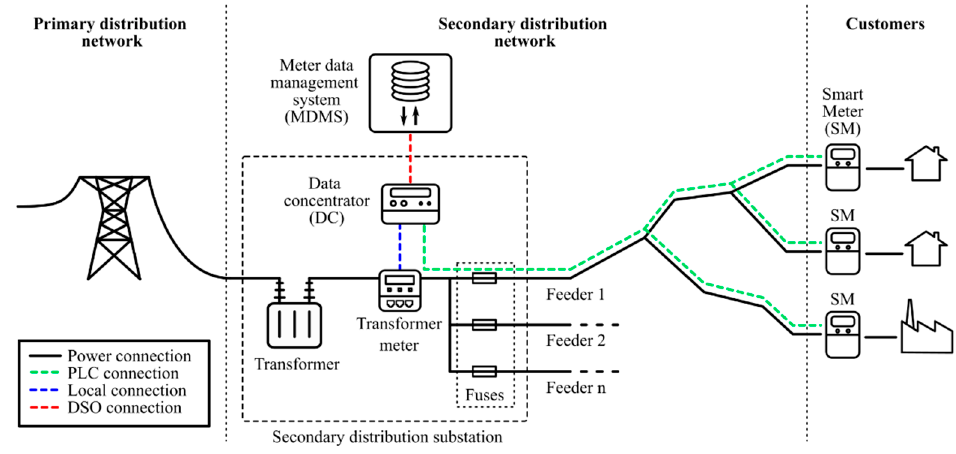
Figure 1. PLC (Power Line Communication)-based smart metering infrastructure [38].